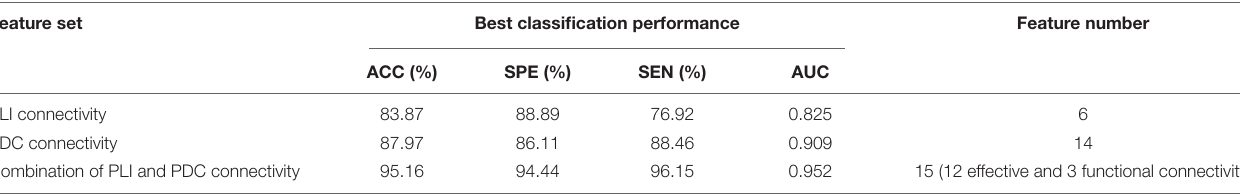
FIGURE 2 | Group average phase lag index (PLI) functional connectivity pattern for schizophrenia (SZ) patients (A) and healthy controls (HCs) (B) , and sparsity was set to 0.3 to obtain a better illustration. Group average partial directed coherence (PDC) effective connectivity pattern for SZ patients (C) and HCs (D) , and sparsity was set to 0.15 to obtain a better illustration. Color bar shows the connectivity strength. Brain connectivity was visualized with the BrainNet Viewer toolbox (http://www.nitrc.org/project/bnv/). TABLE 1 | The obtained best classification performance (ACC, SPE, SEN, and AUC) with the corresponding feature numbers on three different feature sets. Feature set Best classification performance Feature